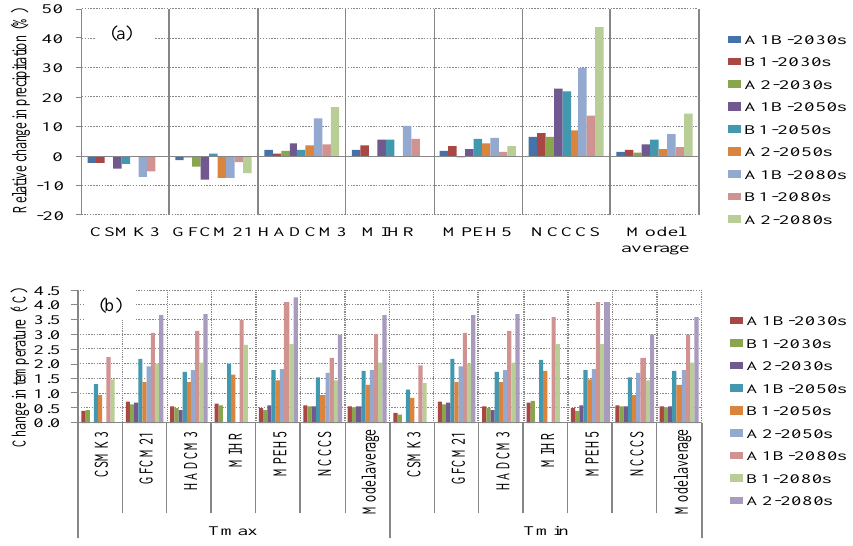
Figure 4. (a) Relative change mean annual precipitation and (b) change in T max and T min modeled from six GCMs for three time periods of UBNRB compared from the reference period of 1984–2011 by using LARS-WG.